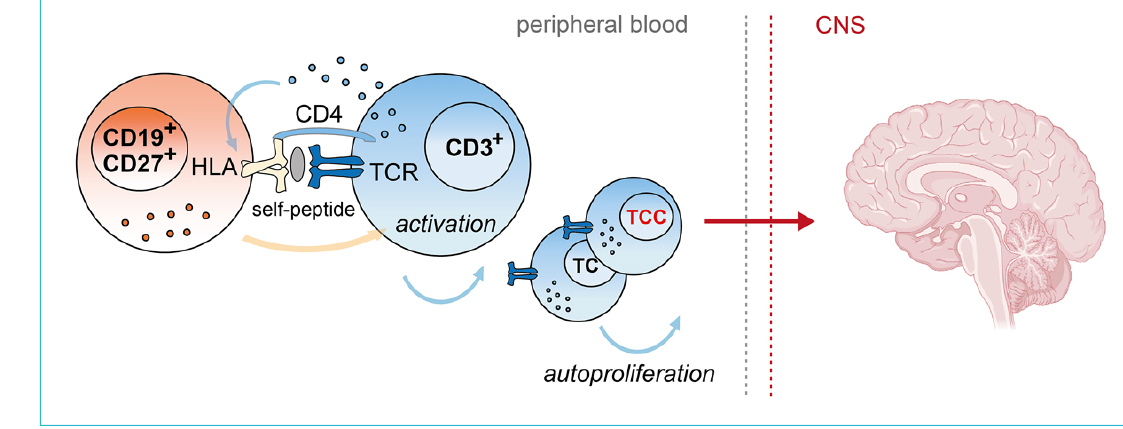
Figure 1: Physical crosstalk in which activation of Th1 cells (blue) by memory B cells (orange) leads to an increased spontaneous cell divi- sion, i.e., autoproliferation, in patients with multiple sclerosis. These autoproliferating T cells are enriched for brain-homing T cell clones (TCCs) that are specific for a protein, RASGRP2, which is expressed in B cells and in the brain. The brain image was created with BioRen-